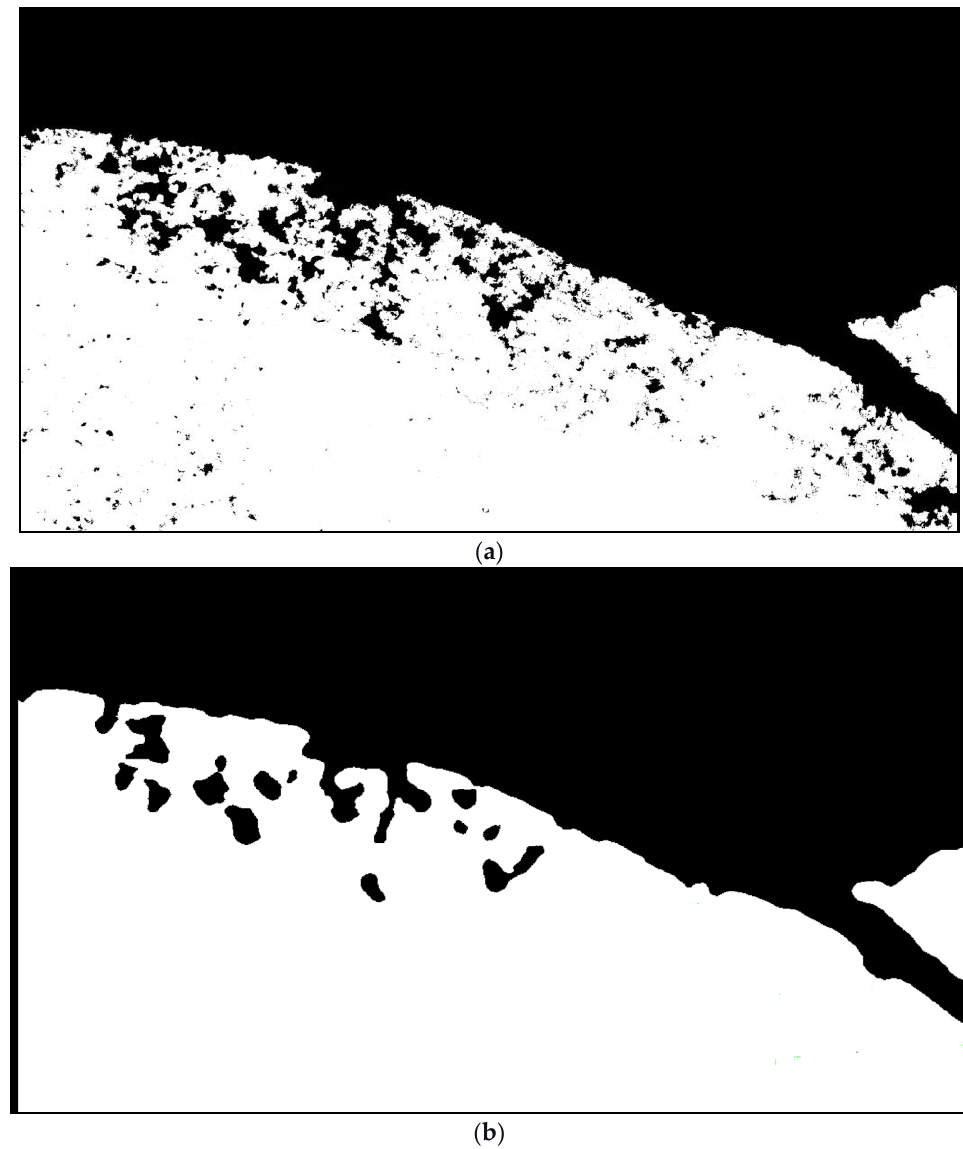
Figure 10. Comparison of Hyperspatial classification with its Denoised Output. White pixels are the burned data and the black pixels are the unburned data. ( a ) example of an image before denoise tool is applied; ( b ) example of an image after denoise tool is applied. These images is a post processing view of the bitmap output data with each pixel containing one class value Burned or Unburned.